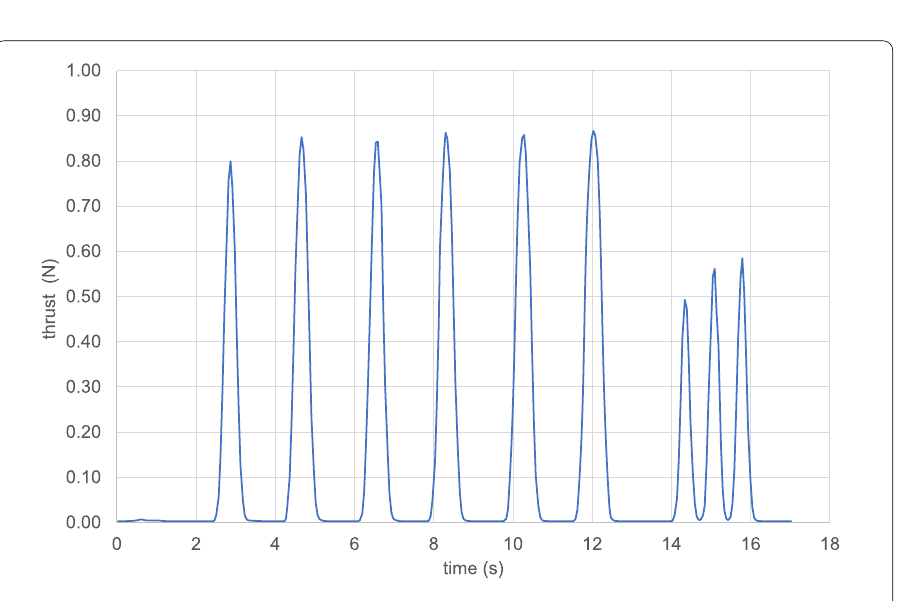
Figure 17 Recording in fast mode with maximum acquisition frequency of 20 Hz. The spikes correspond to load pulses generated by the force